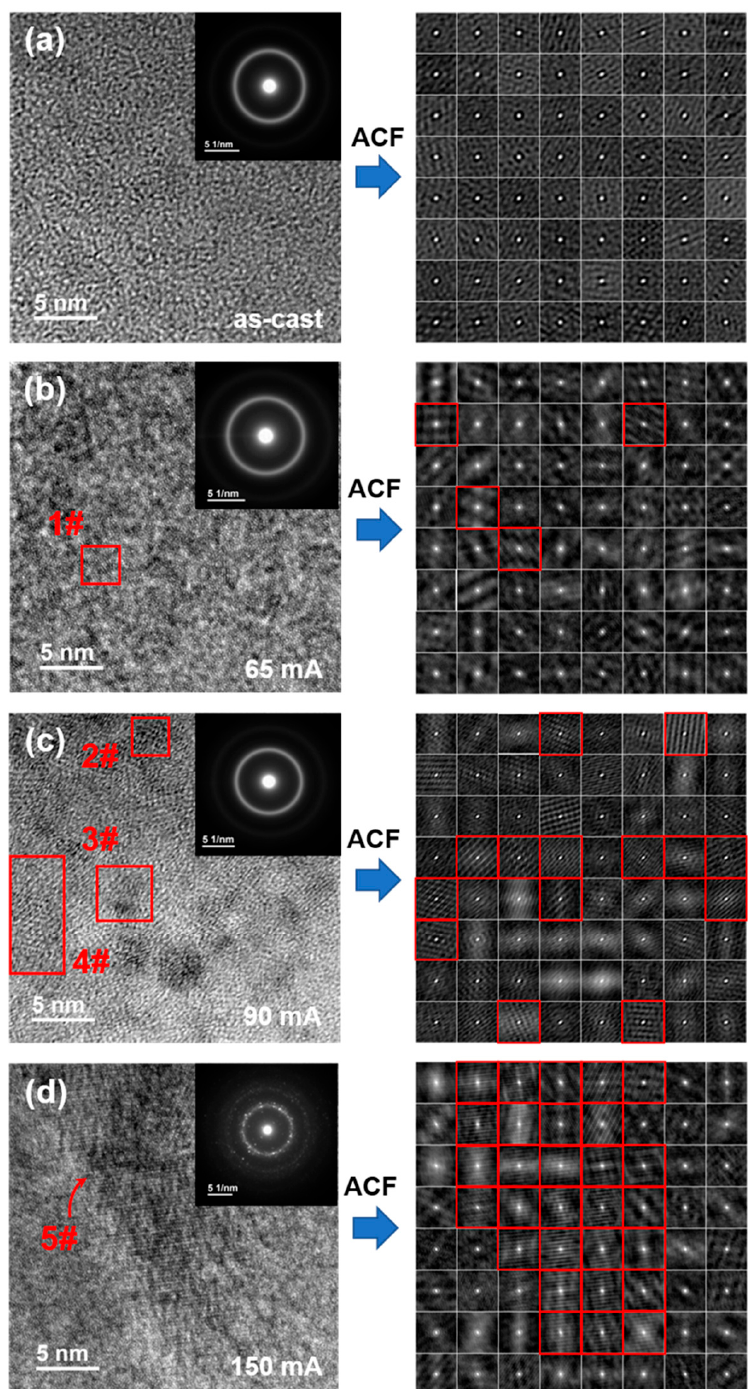
Figure 4. HRTEM images, SAED and ACF of as-cast and direct current-annealed Co-based metallic microwires: ( a ) as-cast; ( b ) 65 mA; ( c ) 90 mA; ( d ) 150 mA. microwires: ( a ) as-cast; ( b ) 65 mA; ( c ) 90 mA; ( d ) 150